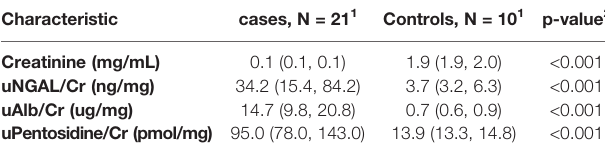
TABLE 5 | Urinary markers in diabetes cohort compared to healthy controls.